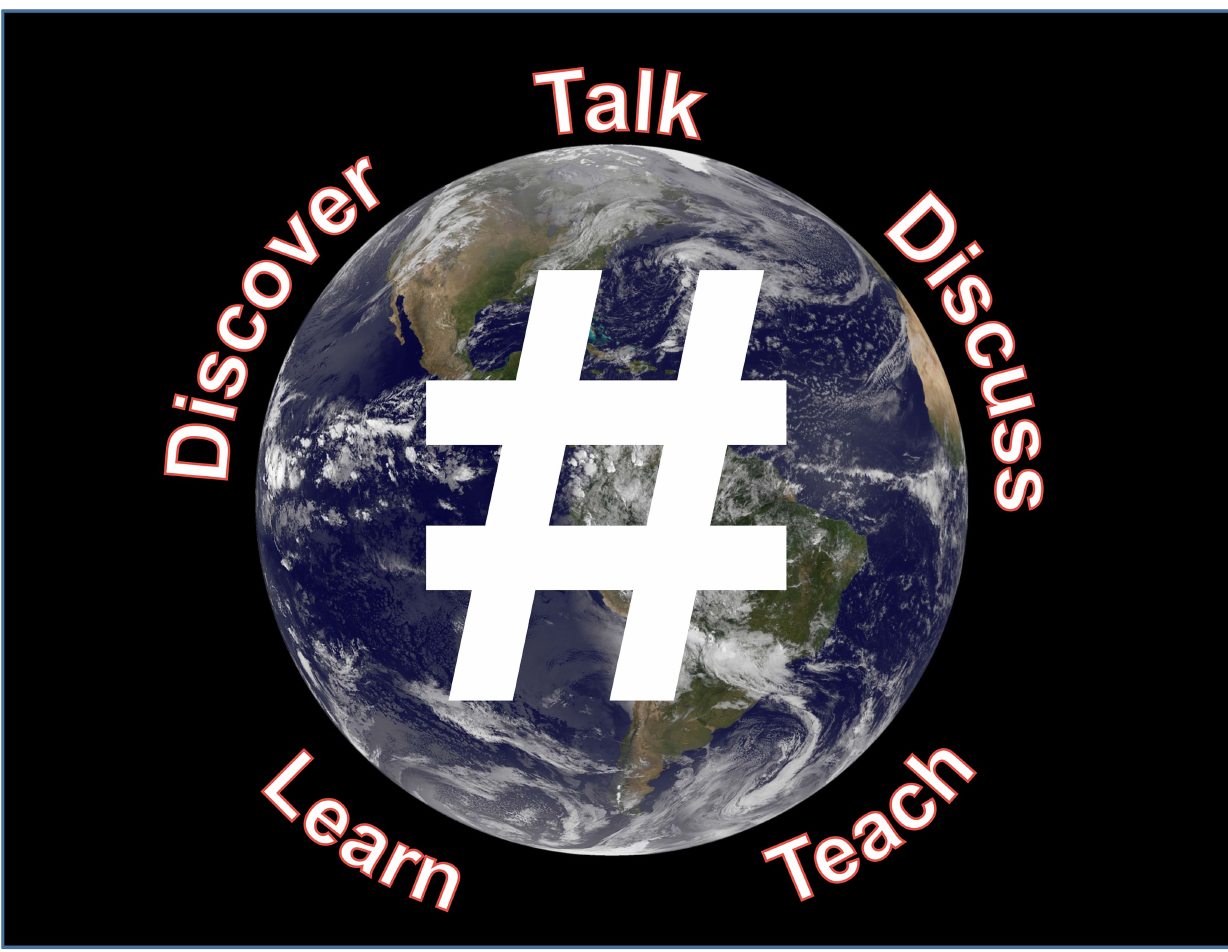
Figure 1. Members of an audience at a scientific conference may tweet what they hear or see, and because these messages are free and open, it has the potential to reach anyone, anywhere in the world. This has profound implications for the communication of science, enabling discovery, discussion, teaching, and learning outside of the confines of the conference itself. Image credit for globe: NASA Goddard Space Flight Center on Flickr.